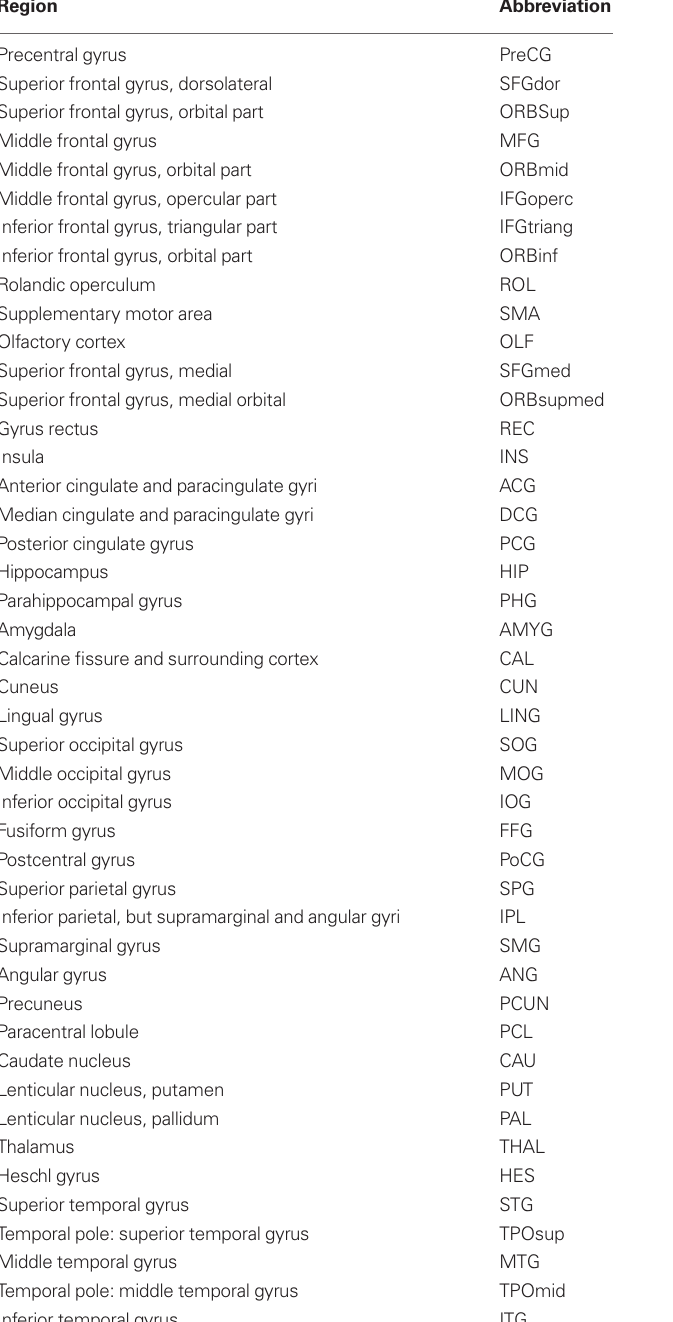
Table A1 | Cortical and subcortical regions in each hemisphere as defined in Tzourio-Mazoyer et al. (2002) , abbreviations as in Salvador et al. (2005)